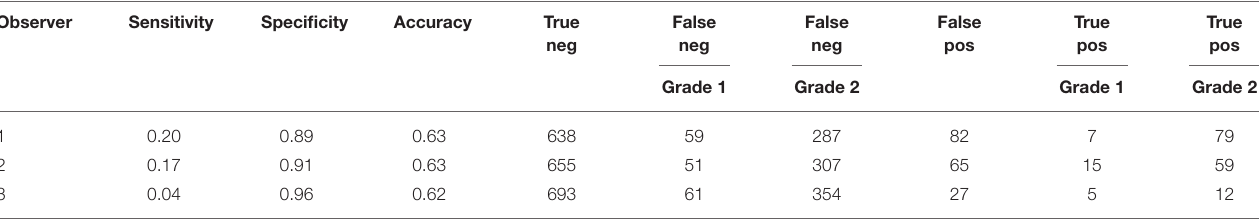
Sensitivity: sum of true positives divided by sum of true positives and false negatives; specificity: sum of true negatives divided by sum of true negatives and false positives; accuracy: sum of true positives and true negatives divided by 1,152.